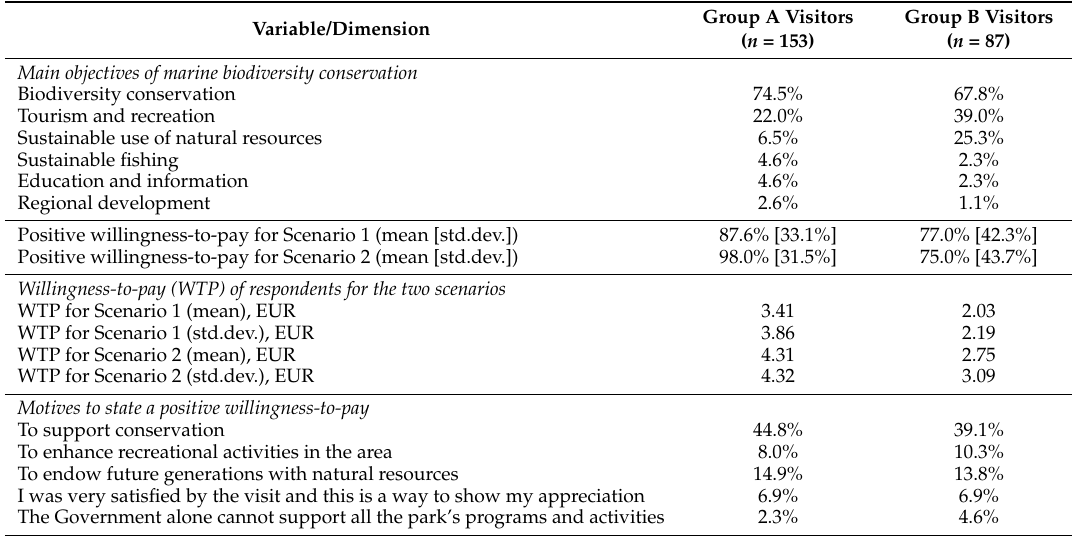
Table 4. Descriptive results: biodiversity conservation and